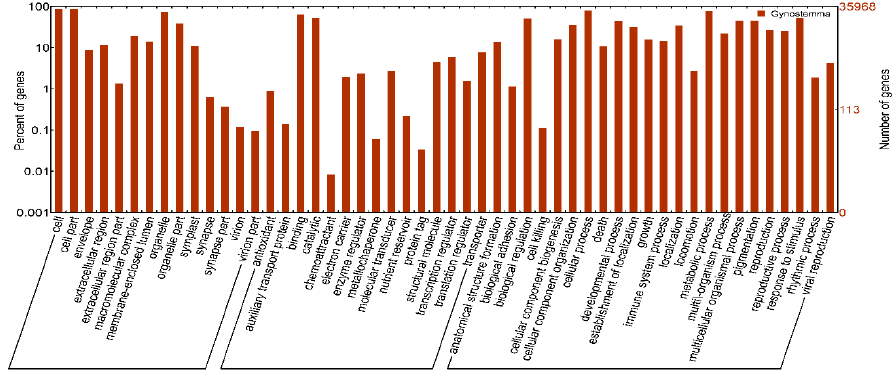
Figure 3. Gene Ontology classification of assembled unigenes. The results are summarized in three main categories: Biological Process, Cellular Component and Molecular Function. In total, 35,968 unigenes with BLAST matches to known proteins were assigned to gene ontology terms.